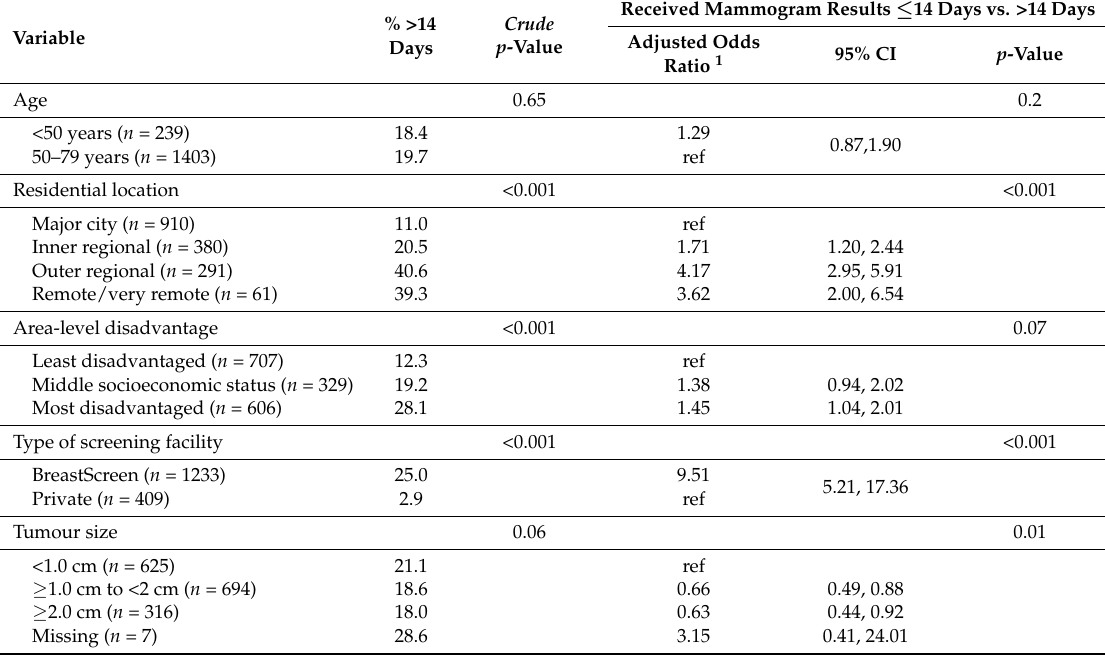
Table 4. Factors associated with delays in receiving mammogram results in 1642 women with screen-detected breast cancer: results of logistic regression